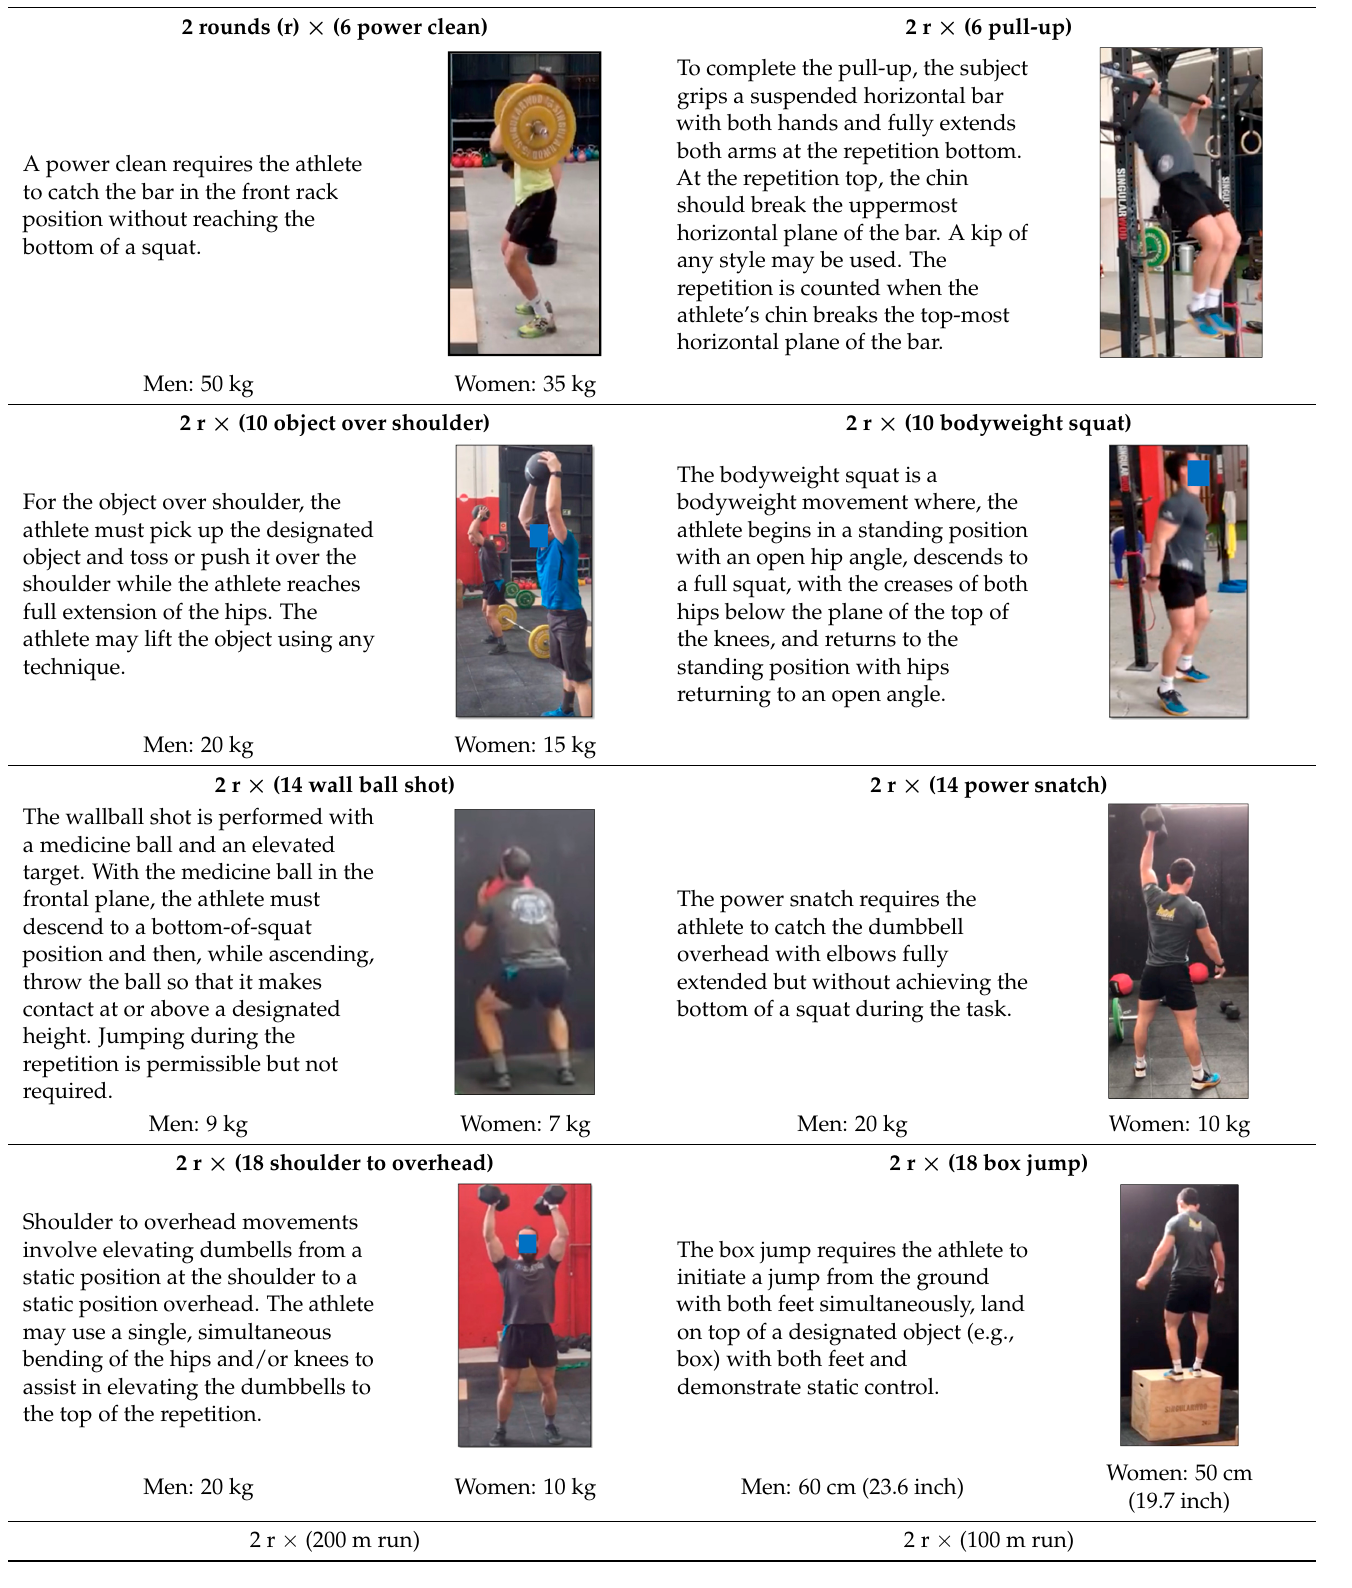
Table 1. FFT workout conducted by the participants of this study. Exercise descriptions taken from the 2021 movements standards set by the iF3. Functional Fitness Training Workout